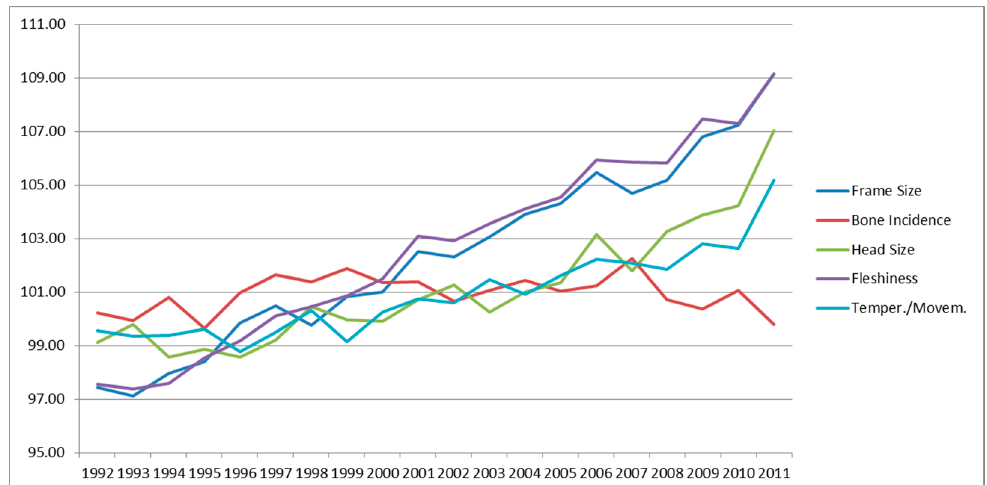
Figure 1. Genetic trends for general linear type traits.